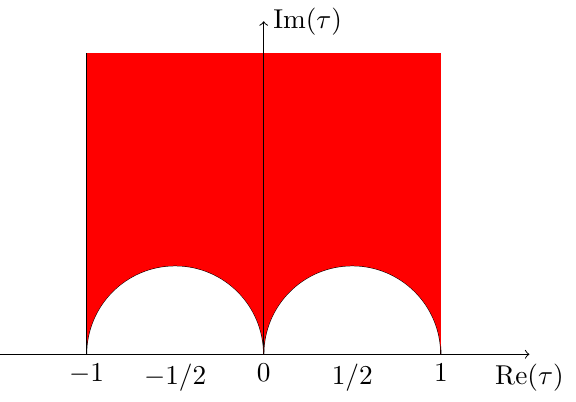
∼ = H / Γ(2) of Γ(2) Γ(2)